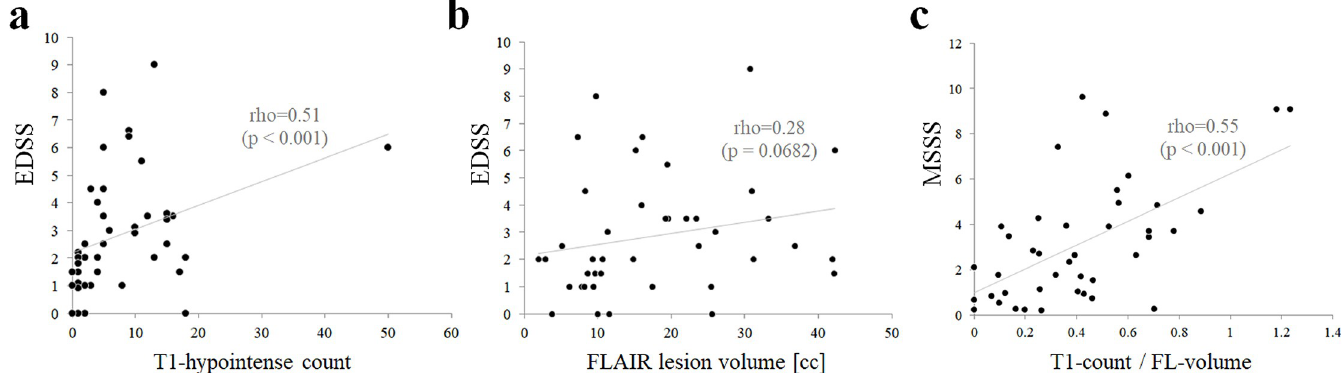
Fig 1. Scatter plots of MRI-derived variables, and neurological disability. (a) Scatter plot of the number of T1-hypointense areas and EDSS. (b) Scatter plot of FL volume and EDSS. (c) Scatter plot of the ratio of T1-hypointense count/FL-volume and MSSS. The grey linear lines are the approximate straight lines. Abbreviations: FL, FLAIR-hyperintense lesion; MSSS, multiple sclerosis severity